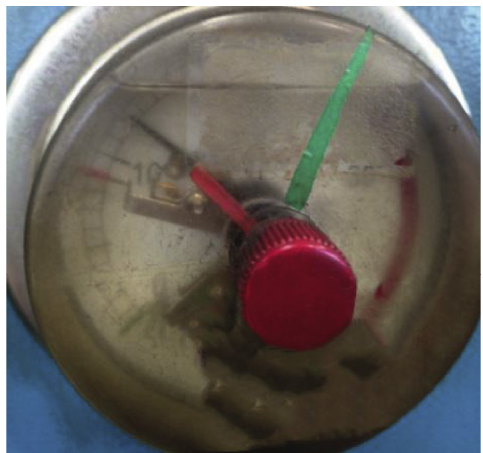
Figure 9: Setting molding pressure.